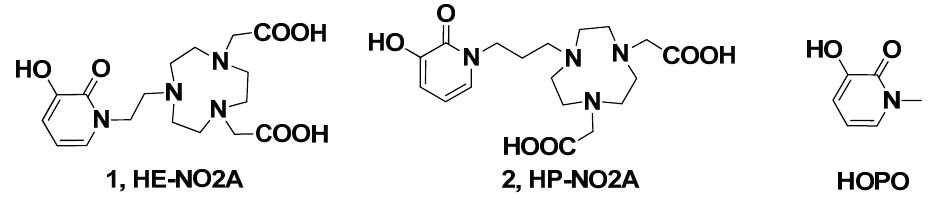
Figure 1. Structures of novel ligands HE-NO2A,